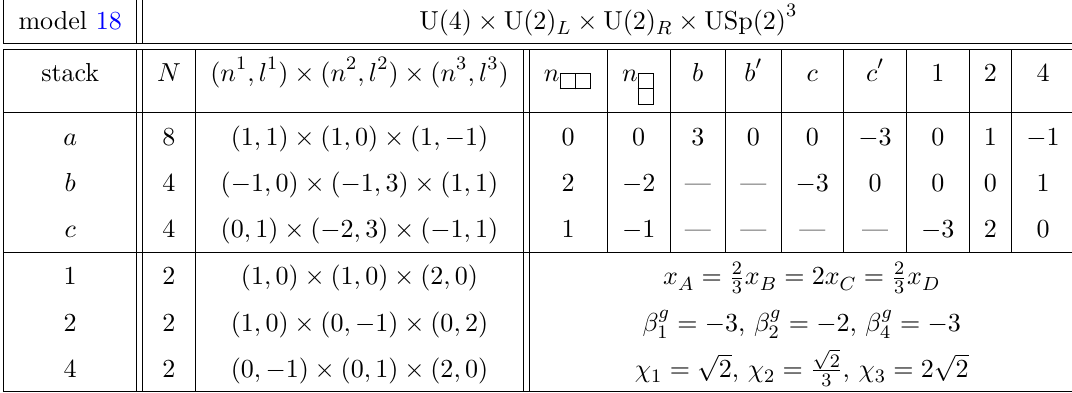
Table 18 . D6-brane configurations and intersection numbers of Model 18, and its MSSM gauge